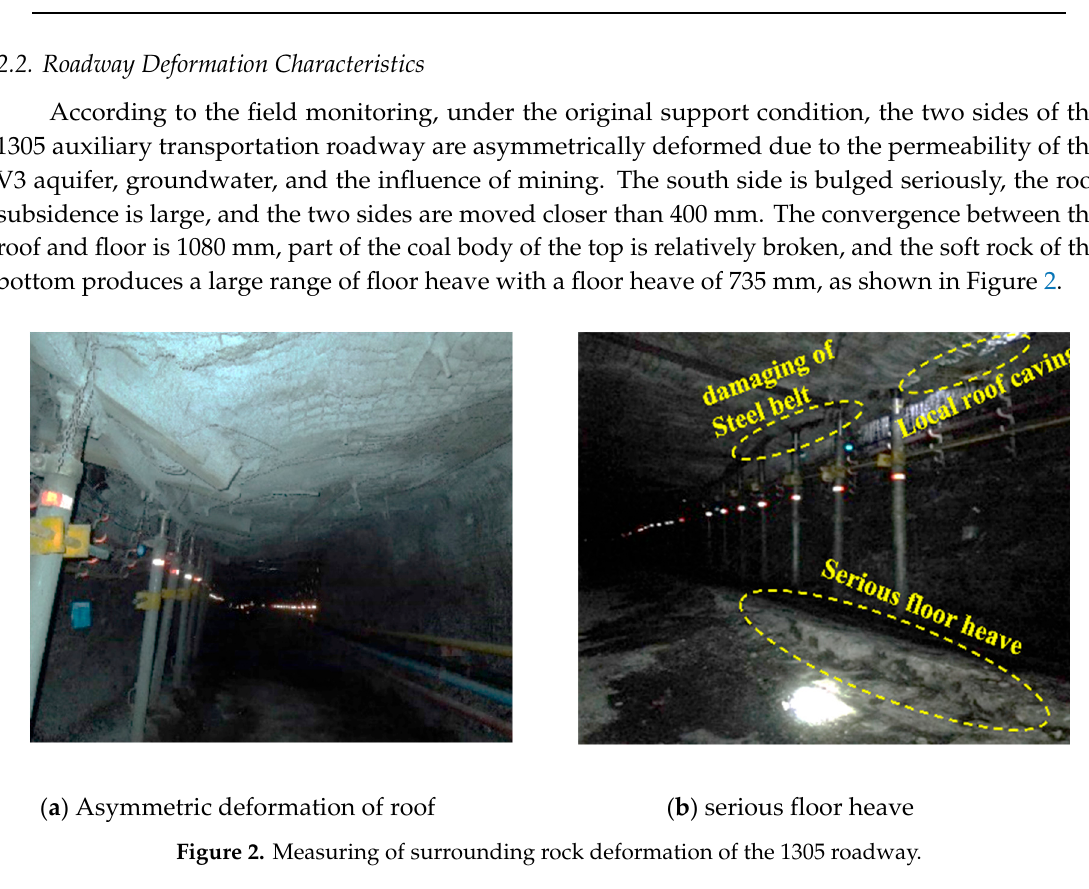
Figure 2. Measuring of surrounding rock deformation of the 1305 roadway.